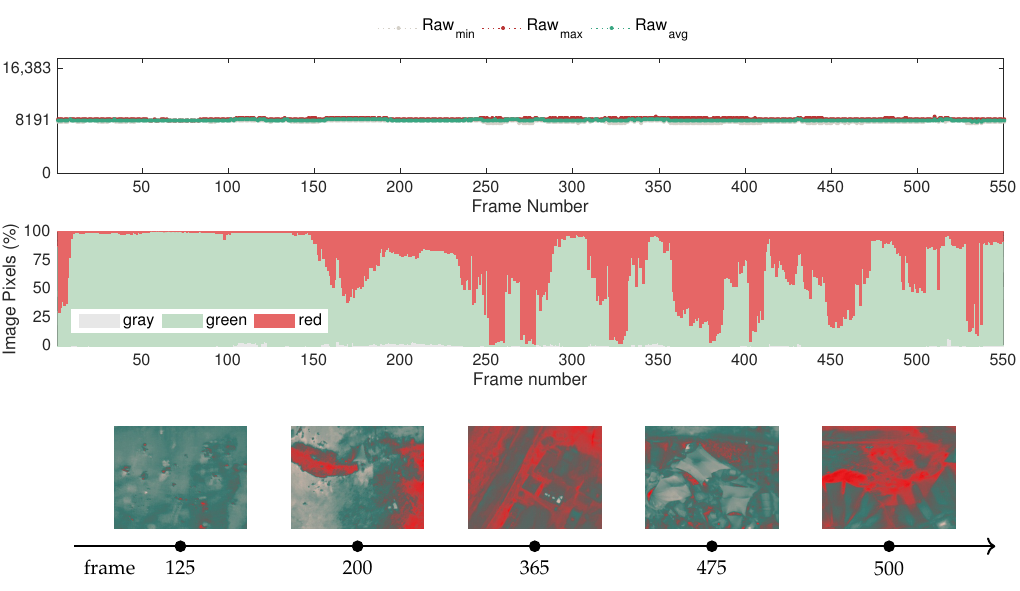
Figure 19. Results for data acquired when surveying the festival venue: raw features ( top ); color features ( center ); sample frames ( bottom